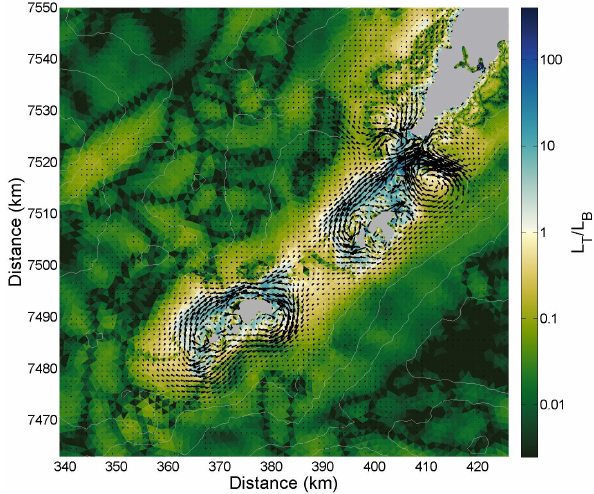
Figure 15. The ratio L T /L B around southern Lofoten. Arrows show the time-mean rectified flow while white contours show bot- tom topography.